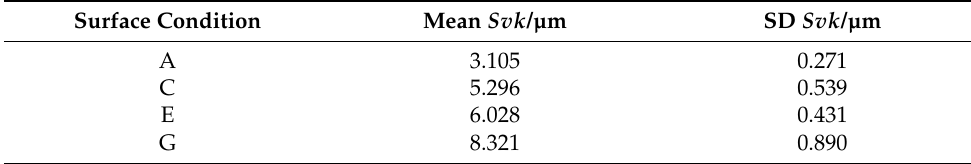
Table 9. Svk for fatigue-tested